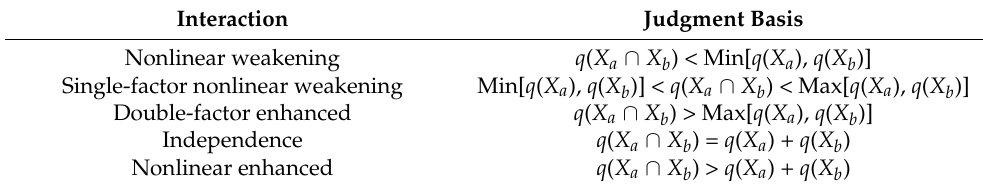
Table 2. Judgment basis of interaction